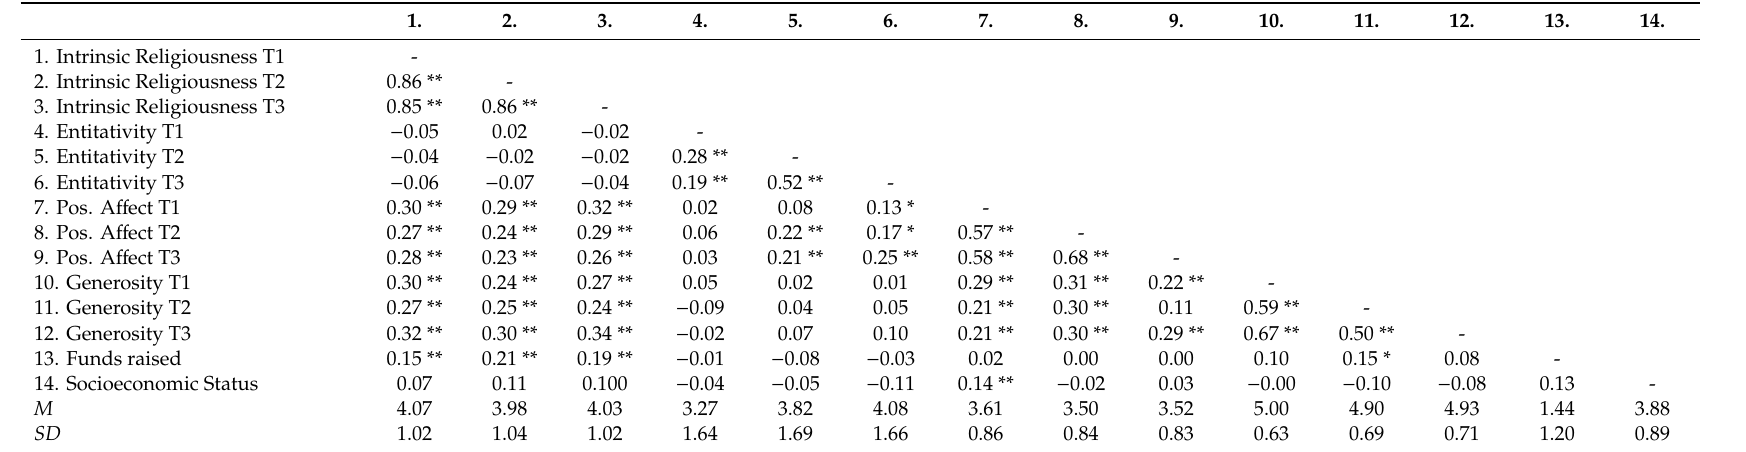
Table 1. Bivariate correlations and descriptive